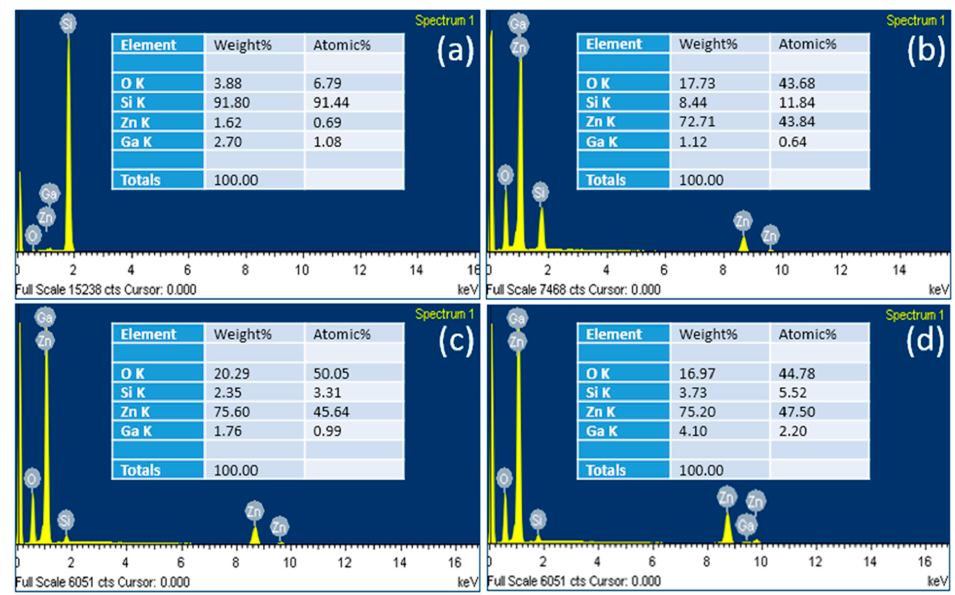
Figure 5. EDS of ( a ) Ga-doped ZnO seeds; and ( b ) 1%; ( c ) 2%; and ( d ) 5% GZRs grown with NH 4 OH treatment.